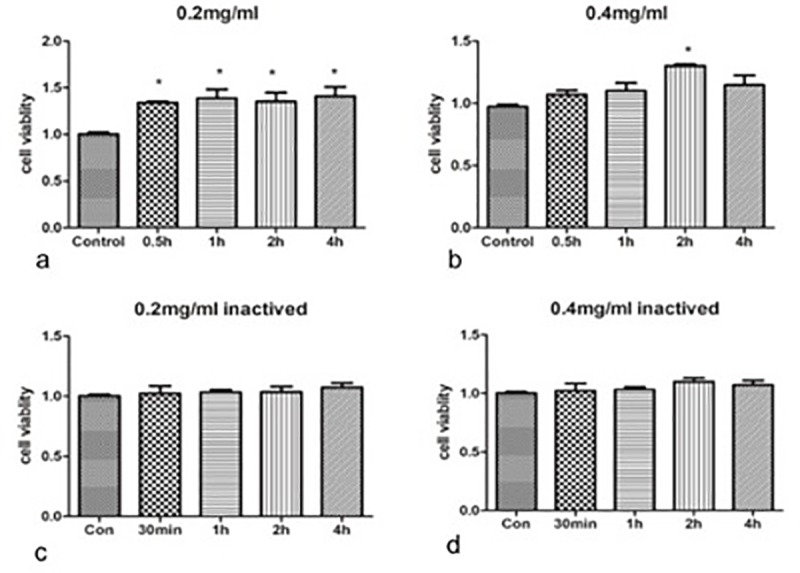
Pepsin increases the growth and proliferation of FaDu cells.FaDu cells were treated with pepsin for the indicated length of time and cultured in fresh complete growth media for 24 hours before analysis. (a) FaDu cells treated with pepsin at a concentration of 0.2mg/ml at pH 7 for 30 min and incubated in fresh media for 24 hours at 37°C. (b) Treatment with pepsin at a concentration of 0.4 mg/mL. (c, d) Treatment with irreversibly inactivated pepsin. Data are from five biological replicates. Bar graphs show mean ± standard deviation. Dose-response data were analyzed by one-way analysis of variance and Tukey multiple comparisons post-test. Time-response data were analyzed by two-way analysis of variance and the Bonferroni multiple comparisons post-test. *P < 0.05.